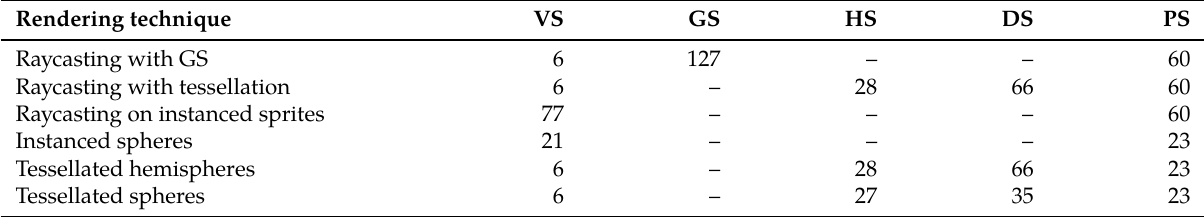
A dash indicates that the shader stage is not used for the respective technique. Note that the tessellated hemispheres use a significantly more complex domain shader than the tessellated spheres, because additional code is required to orient the hemispheres towards the user, whereas the orientation of the spheres is irrelevant.